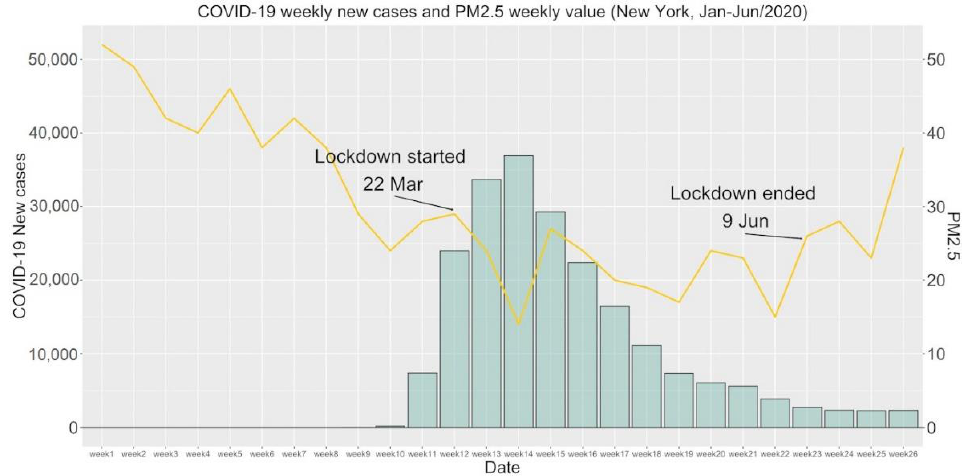
Figure 8. Weekly new COVID-19 cases and weekly PM2.5 values (New York, Jan-Jun/2020). It can be seen from Figures 9 and 10 that PM2.5 dropped in all cities from 2019 to 2020, except for Melbourne. Wuhan had the most significant drops (negative values). In Figure 9, the blue columns representing the change from 2020 to 2021 are all positive; from 2019 to 2021, Wuhan, Seoul, and Singapore are negative, and New York and Melbourne are positive. Figure 10 is a subset of Figure 9, and it shows only four cities during lockdown periods (there was no lockdown in Seoul). Comparing data from Figures 9 and 10, the yearly changing rates from 2019 to 2020 were − 17.81% and − 16.03% in Wuhan, − 11.72% and − 8.47% in New York, and − 15.17% and − 9.56% in Singapore. For details, please refer to Tables 3 and 4. Cities that implemented closures tended to have greater yearly PM2.5 changing rates than those without lockdowns, with the exception of Melbourne.